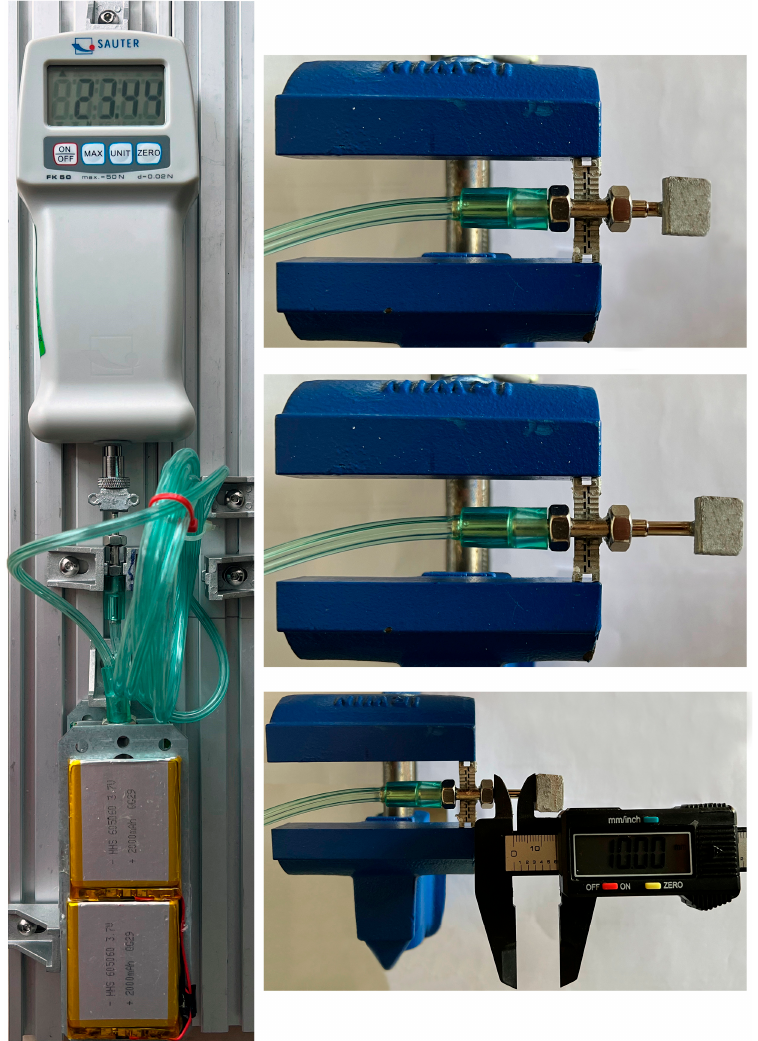
Figure 9. Measurement of the generated force and the linear positioning accuracy.